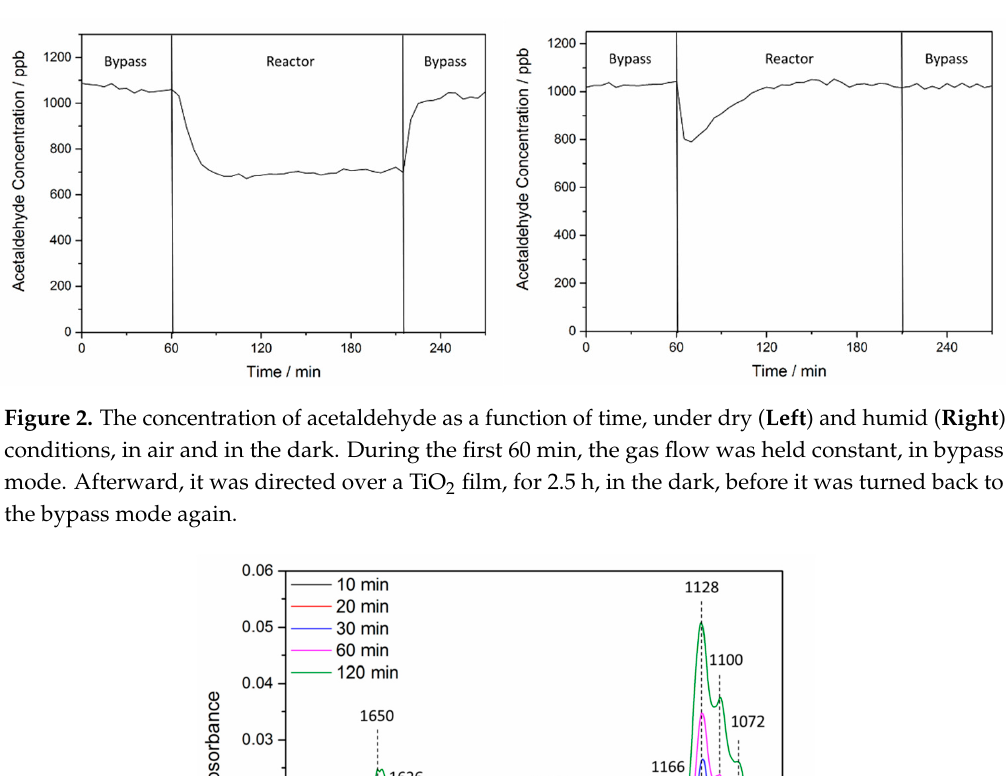
Figure 2. The concentration of acetaldehyde as a function of time, under dry ( Left ) and humid ( Right ) conditions, in air and in the dark. During the first 60 min, the gas flow was held constant, in bypass